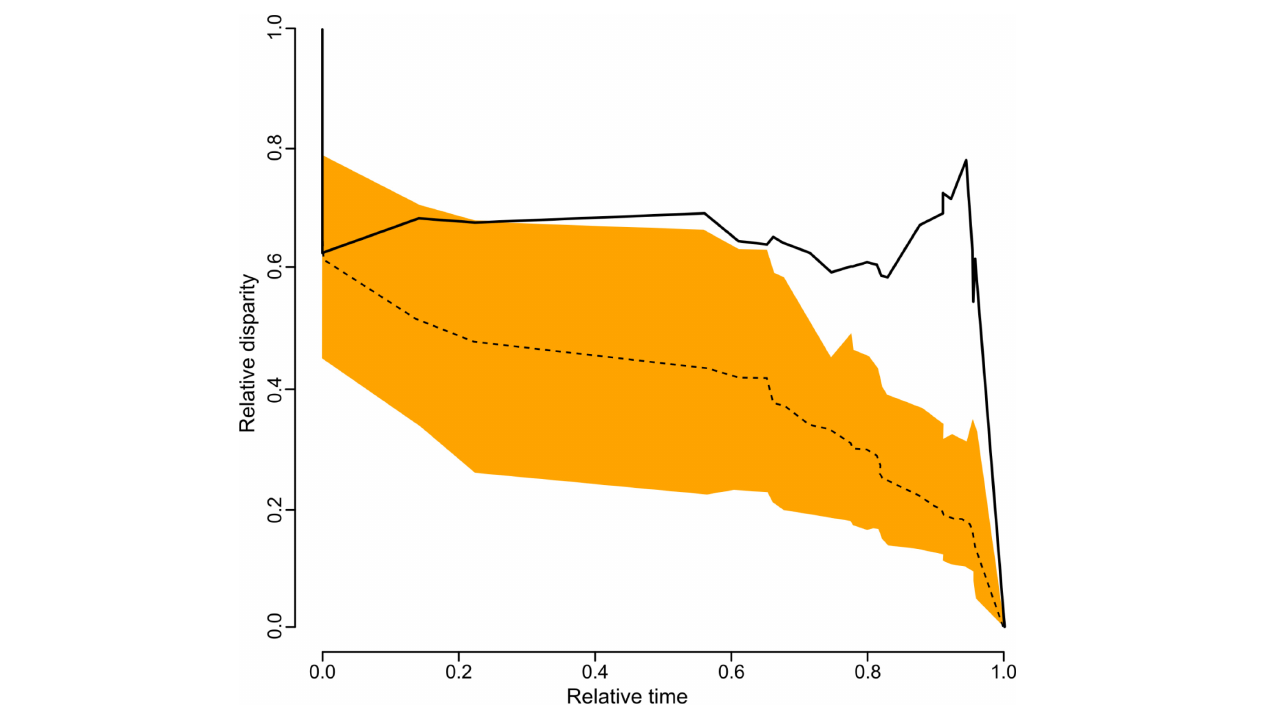
FIGURE 6 | Disparity through time (DDT) based on 100 simulations of phenotypic evolution of antennal response profiles (standardized responses in percent) based on data available for 26 of our 29 tested euglossine species. The relative time ranges from the beginning of the simulated evolution (0.0) to recent times (1.0; equivalent to the tips of the phylogeny in Figure 5 ). The dashed line represents the mean change in disparity across 100 replicates of simulated diversification and trait evolution as expected under a Brownian motion model with a 95% confidence interval of DDT range (orange area). The solid black line represents the actual mean change in disparity as calculated across the